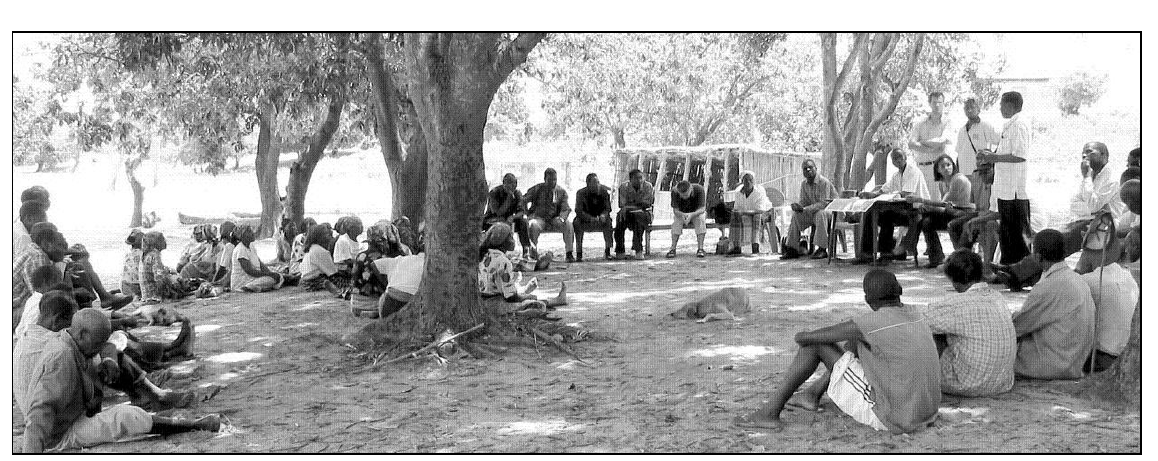
Figure 6. Participatory meeting in Chilaulene, Gaza Province,